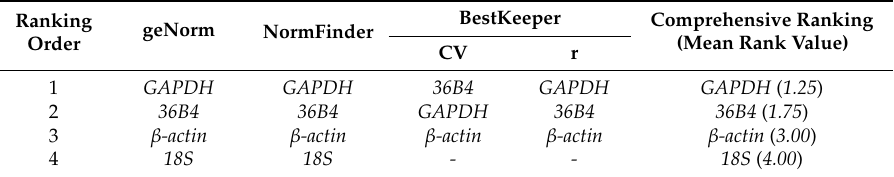
Table 4. Comprehensive ranking